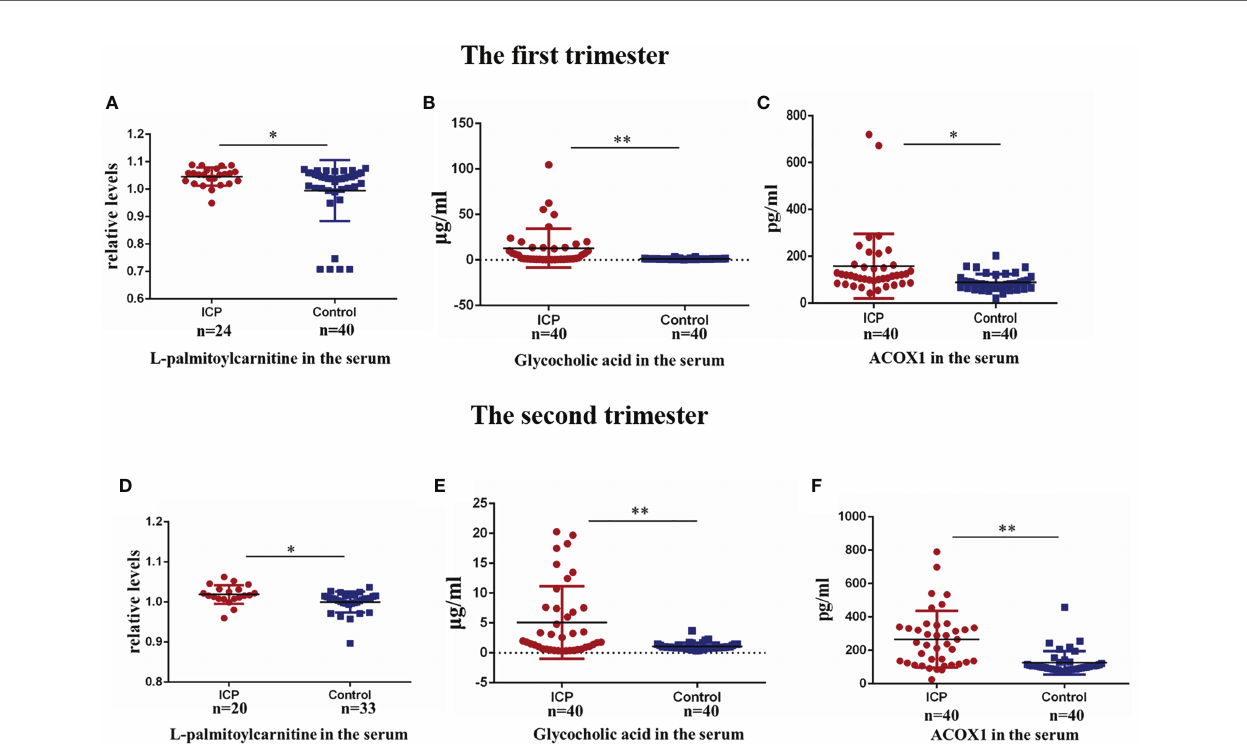
FIGURE 4 | Validation of alteration in biomarker levels in the fi rst and second trimester. (A) Serum levels of L-palmitoylcarnitine in the fi rst trimester(P=0.040); (B) serum levels of glycocholic acid in the fi rst trimester (P=0.000); (C) serum levels of ACOX1 in the fi rst trimester (P=0.022); (D) Serum levels of L-palmitoylcarnitine in the second trimester(P=0.012); (E) serum levels of glycocholic acid in the second trimester (P=0.000); (F) serum levels of ACOX1 in the second trimester (P=0.000). (*P < 0.05; **P < 0.01).